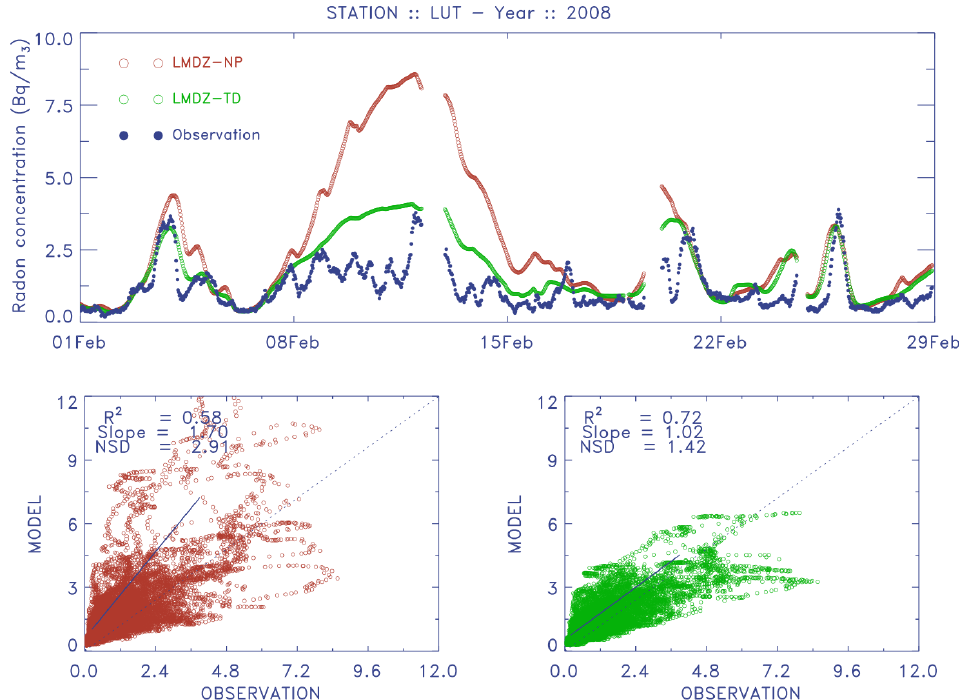
Figure 6. Time series of 222 Rn hourly concentrations at Lutjewad in February 2008. Red (Green and Blue) time series refer to NP simulation (TD simulation and observations, respectively). Scatter plots for NP and TD are also showed with main statistic diagnostics ( R 2 , normalized standard deviation (NSD) and slope coefficient of the linear regression). NSD is the ratio between the standard deviation of simulated 222 Rn concentrations by the standard deviation of observed 222 Rn